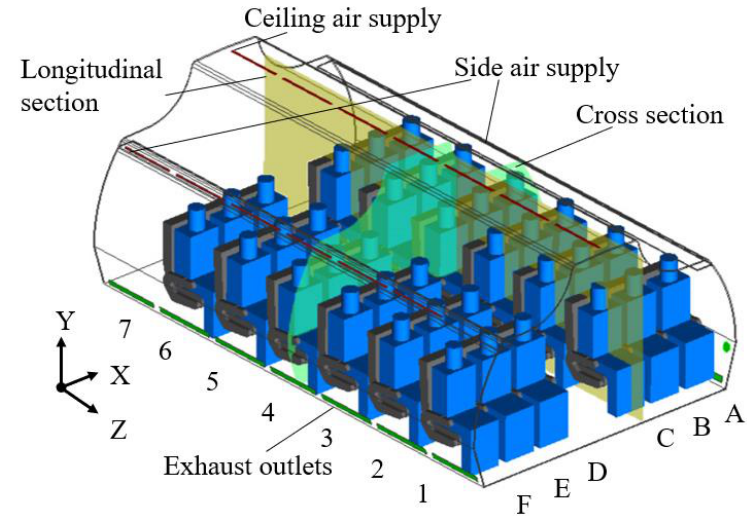
Figure 4. The geometry of the cabin mock-up.